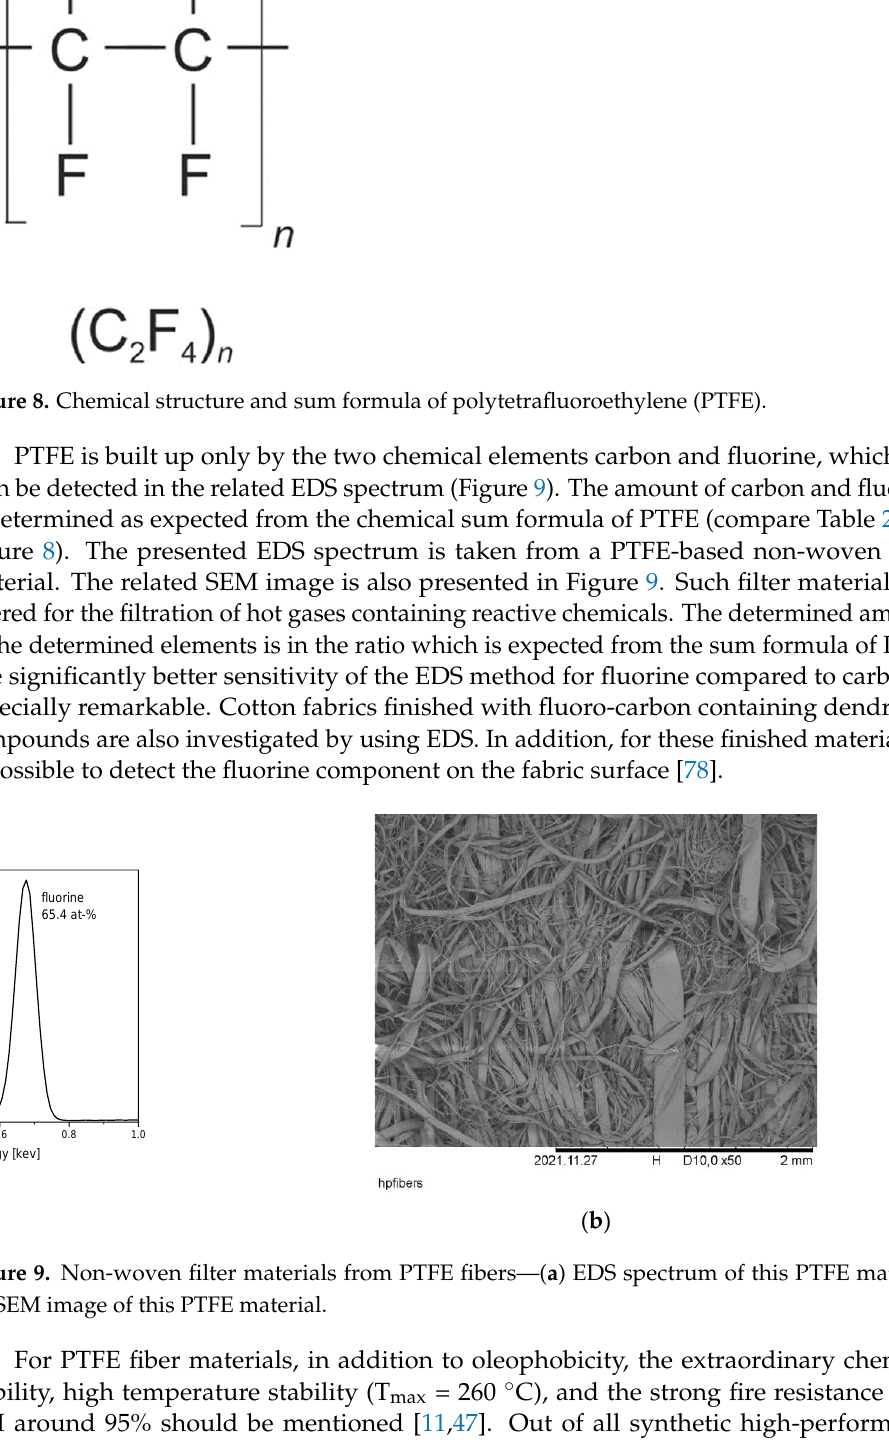
Figure 8. Chemical structure and sum formula of polytetrafluoroethylene (PTFE).